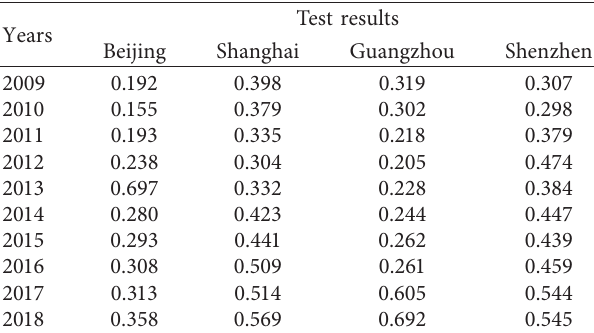
Table 3: Test results based on the topsis